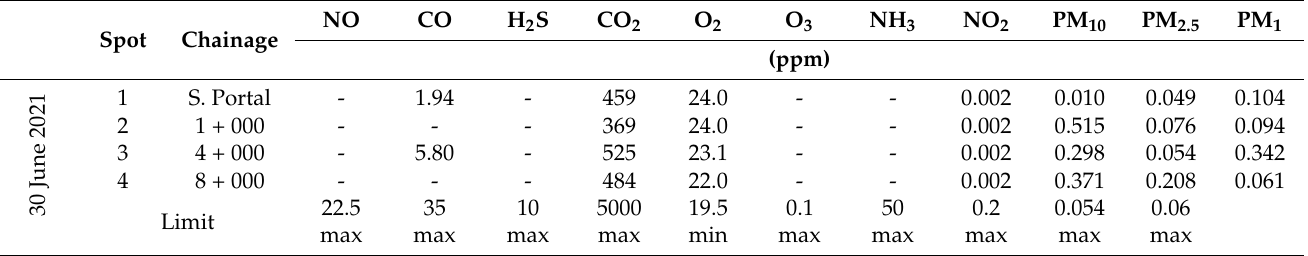
Table 2. Gas and particulate matter concentrations during the operational